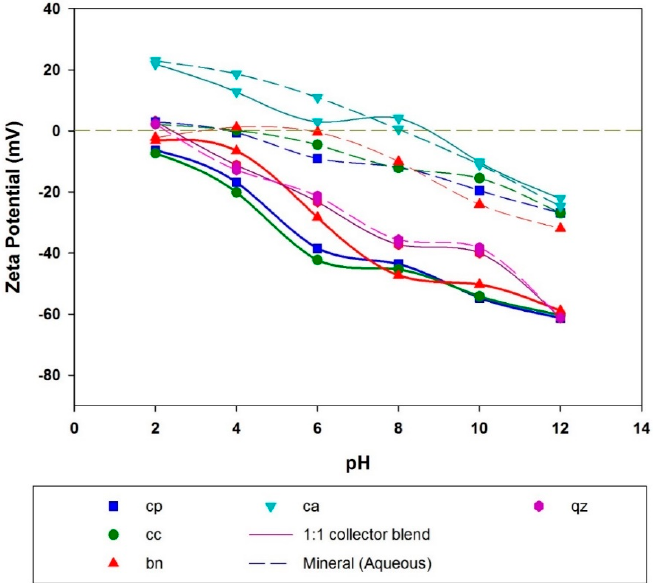
Figure 2. Zeta potentials of copper and gangue minerals in a mixed collector system (1:1 ratio of Sodium Isobutyl xanthate: n -Butoxycarbonyl- O - n -butyl thionocarbamate(SIBX:BBT), both added simultaneously) as a function of pH. cp-chalcopyrite, cc-chalcocite, bn-bornite.